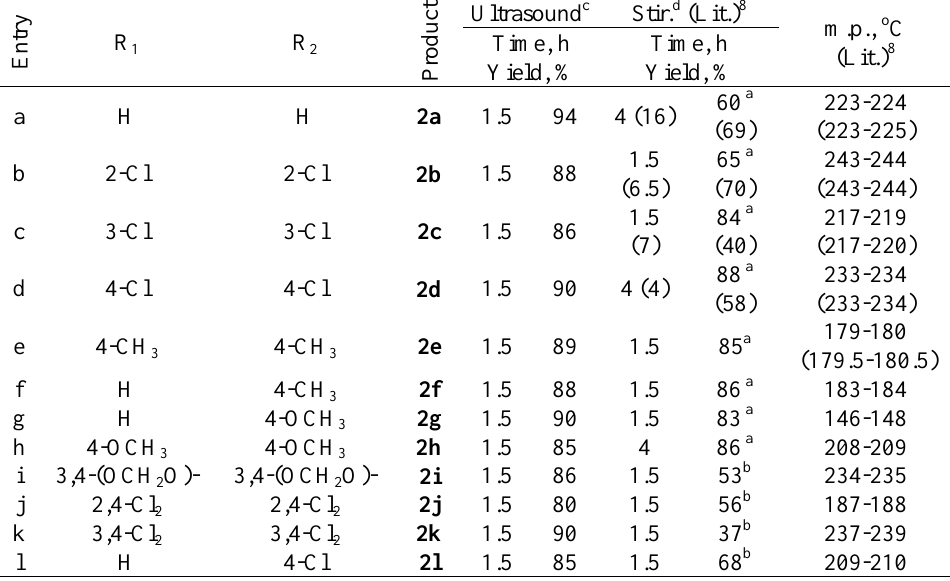
Table 2. The synthesis of 2a-l with or without ultrasound